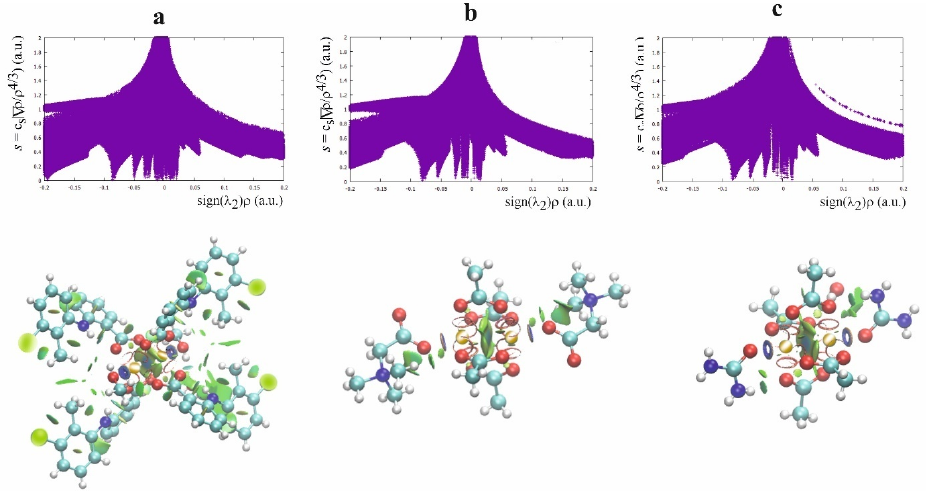
Figure 5. NCI diagram and NCI plot for [Cu II 2 (Tolf) 4 (MeOH) 2 ] · 2MeOH ( a ), QEBQIX ( b ), and ACURCU01 ( c ).